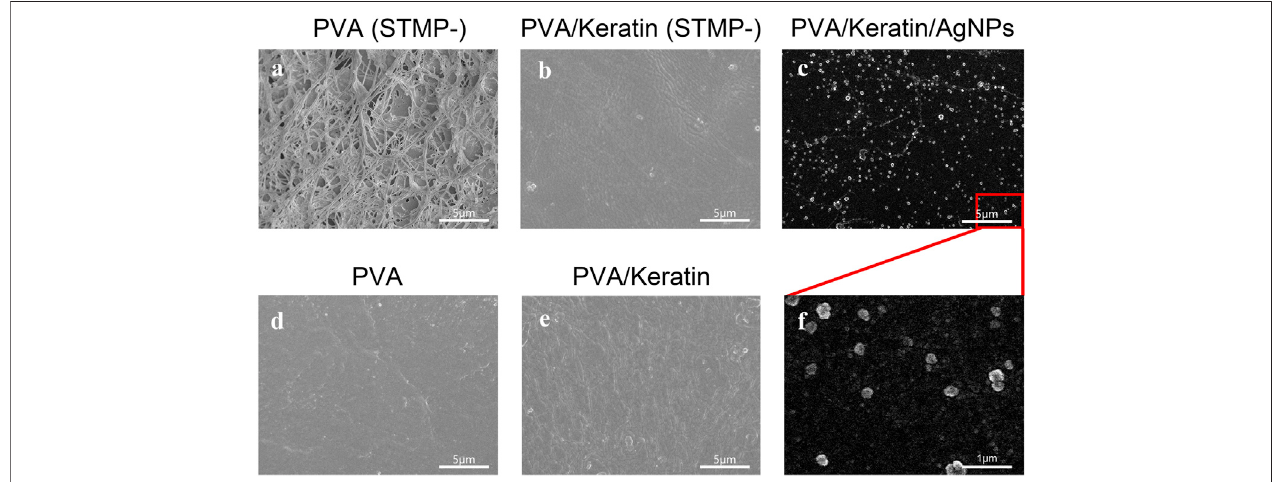
FIGURE 1 | Microstructure of (A) PVA without crosslinking by STMP, (B) PVA/Keratin without crosslinking by STMP, ( C) PVA/Keratin/AgNPs at bar (cid:1) 5 μ m, (D) PVA after crosslinking by STMP, (E) PVA/Keratin after crosslinking by STMP, (F) PVA/Keratin/AgNPs at bar (cid:1) 1 μ m.